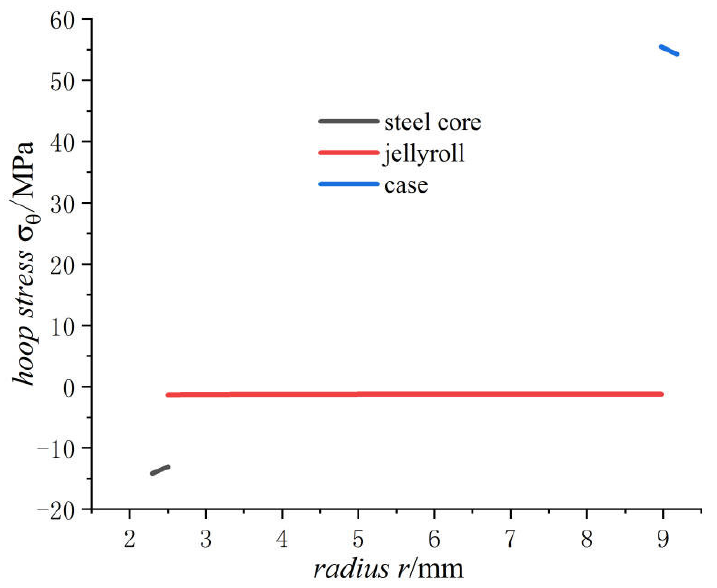
Figure 6. Hoop stresses of 18650 battery on a fully charged state.